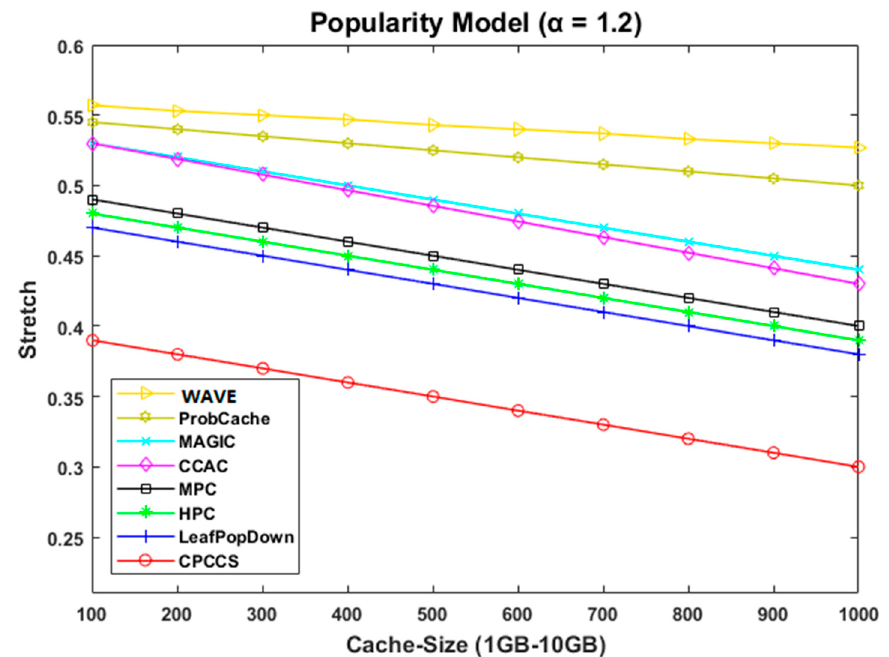
Figure 7. Stretch with VoD.